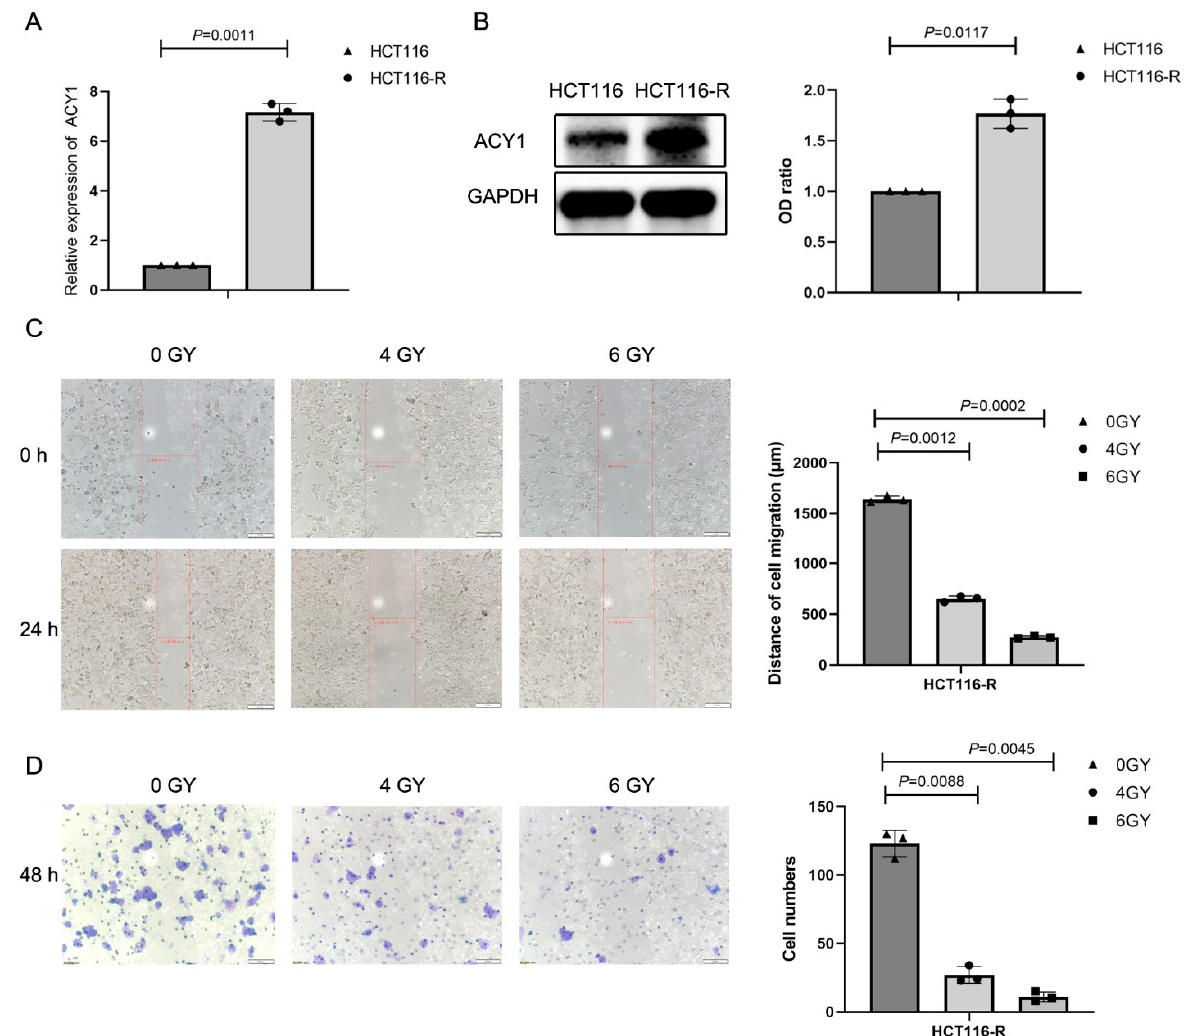
Figure 5. Radiotherapy affects the migration and invasion ability of HCT116 ‐ R cells. ( A ) The expression of ACY1 in HCT116 and HCT116 ‐ R cells was examined by qRT ‒ PCR. ( B ) The expression of ACY1 in HCT116 and HCT116 ‐ R cells was examined by Western blotting. ( C ) Wound healing migration assay showing the impact of different doses of radiotherapy on HCT116 ‐ R cells (24 h). ( D ) Invasion assay showing the impact of different doses of radiotherapy on HCT116 ‐ R cells (48 h). All experiments were repeated at least three times, and the data are presented as the mean ± SD.